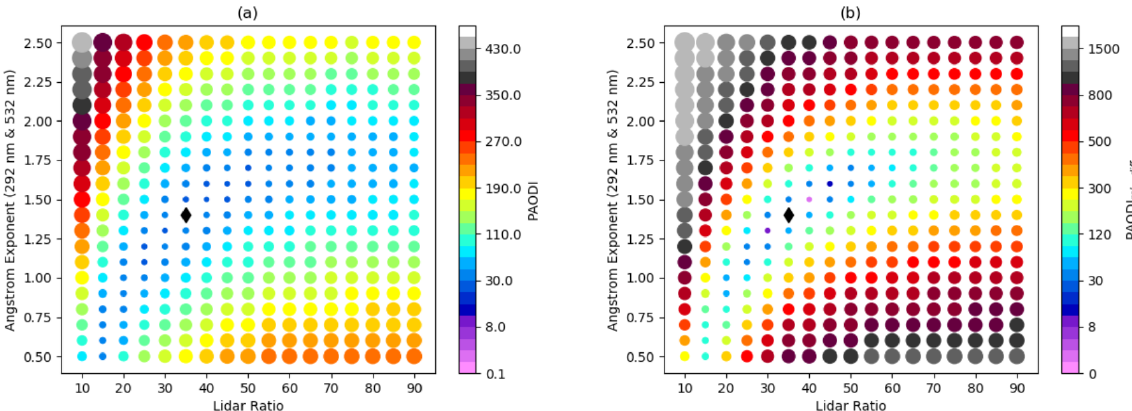
Figure 4. (a) The distribution of PAODI according to the 292nm S 1 and AE (292 and 532nm). The marker color and size show the value of PAODI. The PAODI min was found, and the corresponding S 1 and AE (292 and 532nm) are noted as a black diamond. (b) The distribution of PAODI rel − diff . The marker size and color show the value of PAODI rel − diff . Black diamond shows the minimum value of PAODI rel − diff and indicates the ideal S 1 used for optimized 292nm aerosol retrieval.